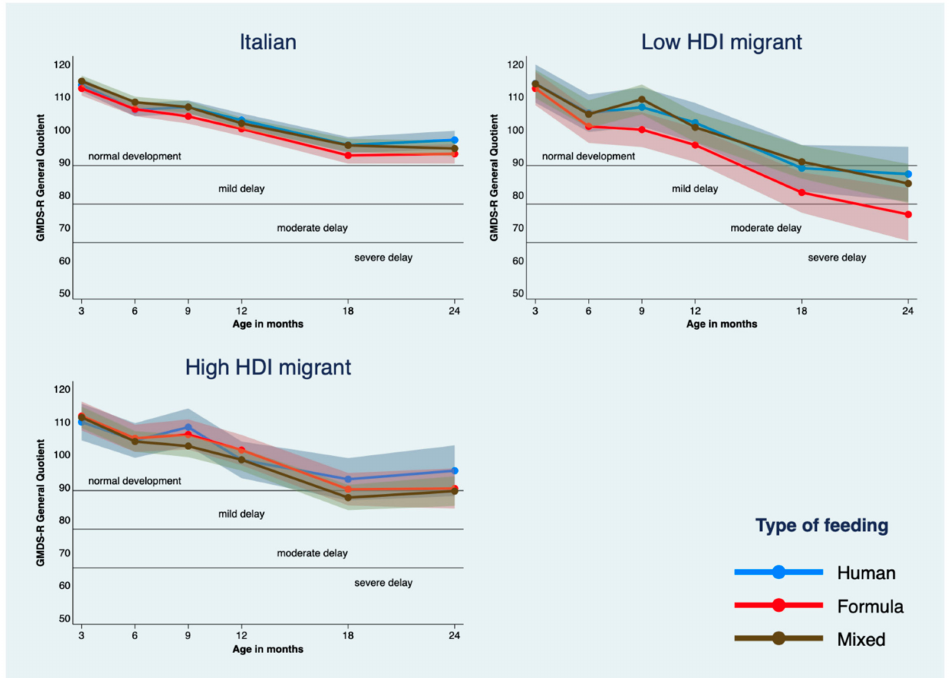
Figure 3. GMDS-R general quotient trajectories and 95% confidence intervals estimated by using mixed-effects modeling, by mother’s origin and type of milk feeding and adjusted for mother’s smoking status, and infant intraventricular hemorrhage or periventricular leukomalacia (IVH / PVL), sepsis, bronchopulmonary dysplasia (BPD), mechanical ventilation, and small for gestational age (SGA) at discharge.